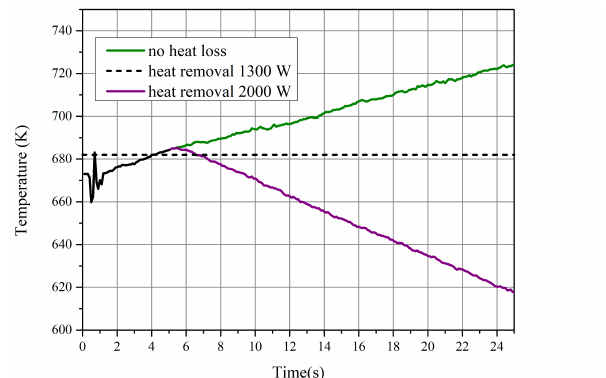
Figure 7. Profile of the time-evolution gas temperature. Dashed line: reference case with heat removal, 1300 W. Green line: no heat removal. Purple line: heat removal 2000